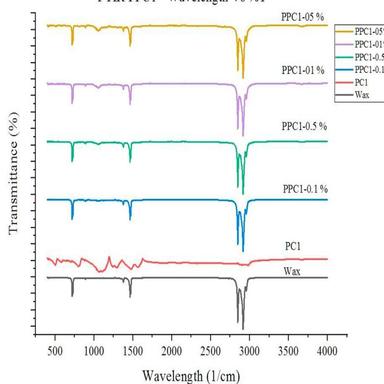
FTIR spectrum for PPC1 - Wavelength Vs %T.